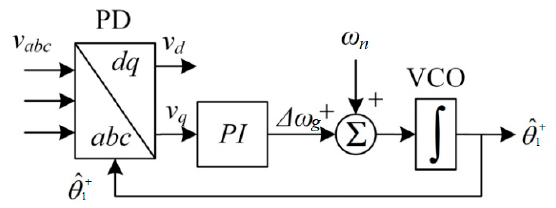
Figure 3. Block diagram of SRF-phase-locked loop (PLL).